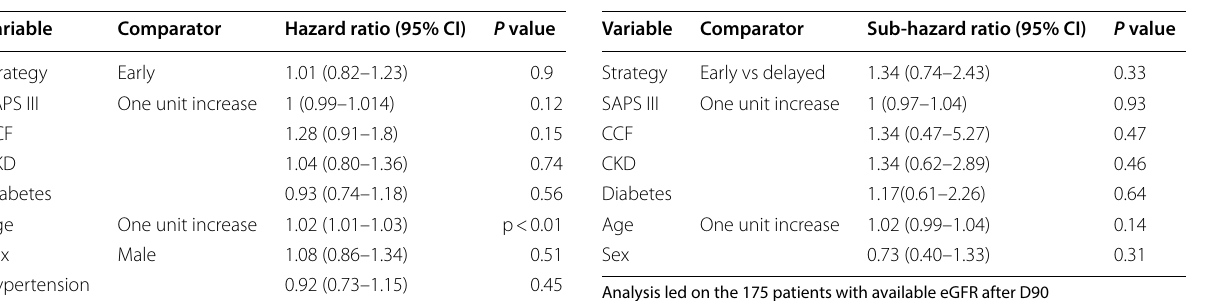
Table 3 Univariable analysis of subdistribution hazard ratios for factors associated with WRF